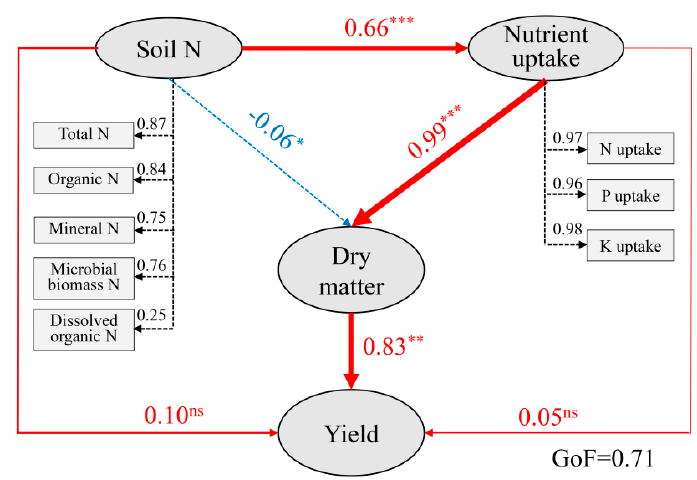
Figure 7. Partial least squares path model based on the effects of soil N fractions, nutrient uptake, and dry matter production on maize grain yield. The loading for soil N pools and plant nutrient uptake that create the latent variables are shown in rectangles. Numbers adjacent to arrows are standardized path coefficients. Continuous red and dashed blue arrows indicate positive and negative effects, respectively. Width of arrows is proportional to the strength of path coefficients. Coefficients differing significantly from zero are indicated by ** p < 0.01, and *** p < 0.001; ns, not significant. The model is assessed using the goodness of fit (GoF) statistic, a measure of overall prediction performance.